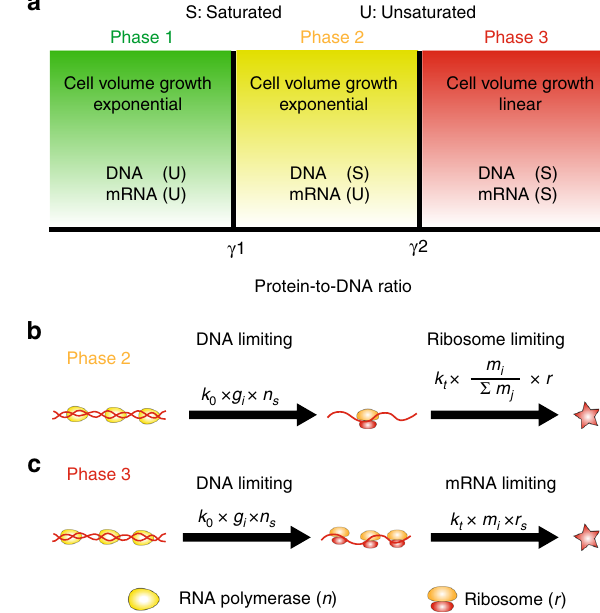
Fig. 4 Phases of gene expression and cell volume growth. a Theoretical phase diagram of gene expression and cellular growth within our model.